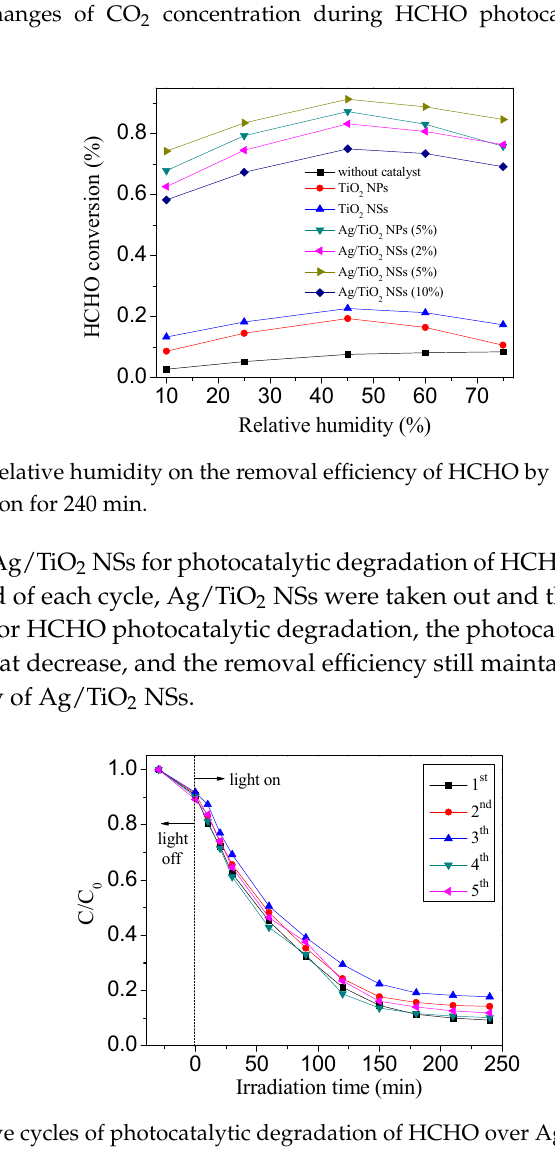
Figure 12. Five cycles of photocatalytic degradation of HCHO over Ag/TiO 2 NSs